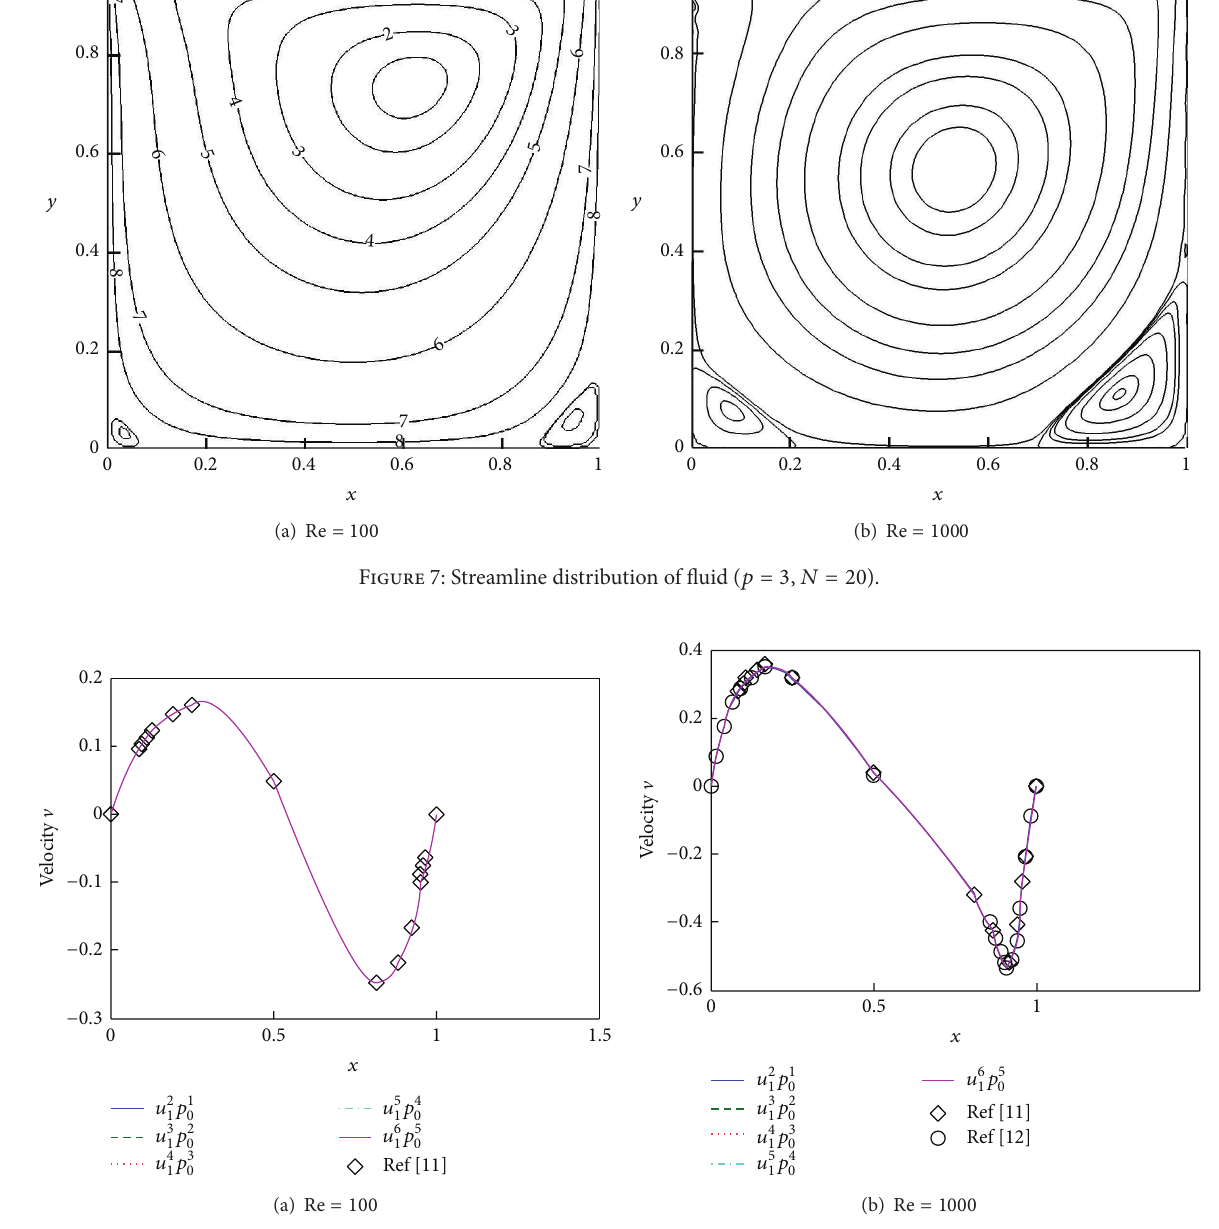
Figure 8: Velocity magnitude along parallel